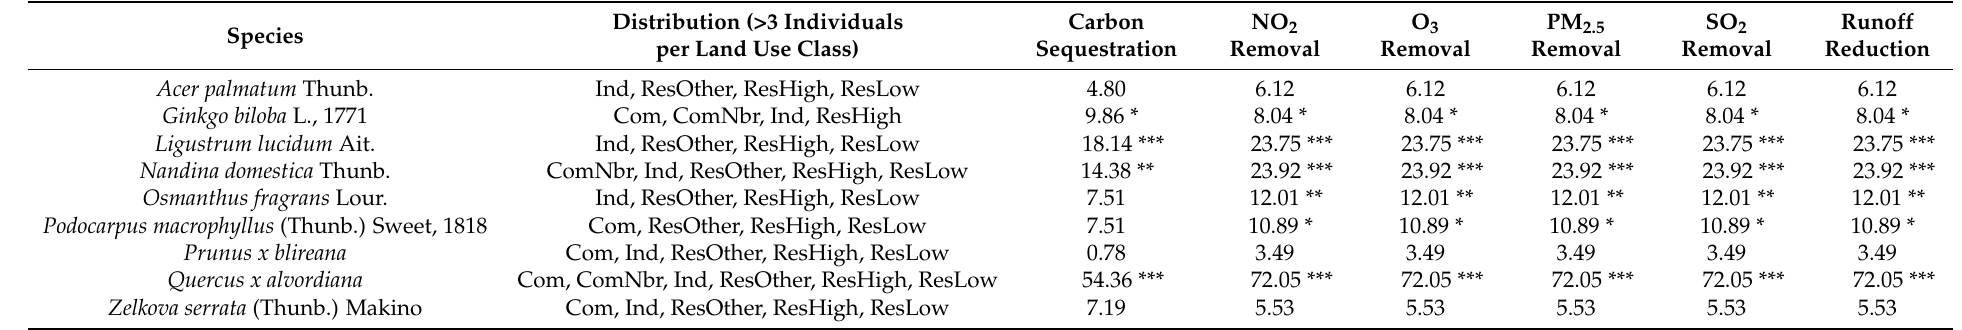
Table 4. Chi-square statistics of species-specific comparison of ecosystem services across land use classes by Kruskal–Wallis rank sum test (the level of significance